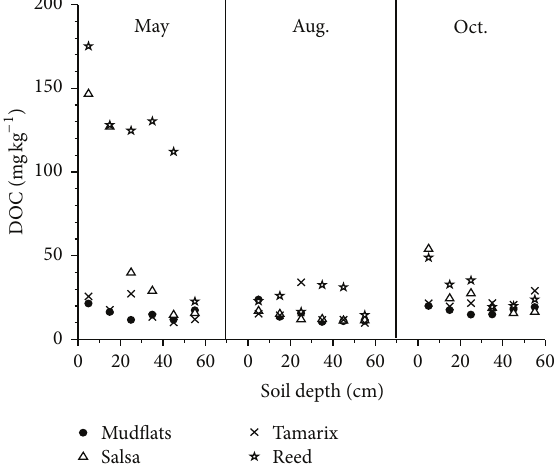
ReedTamarixSalsaMudflatsReedTamarixSalsaMudflatsReedTamarixSalsaMudflats Figure 3: Soil DOC content in four types of Yellow River estuary wetlands. The columns represent the average content of soil TOC, the lines represent the variation range, the number at the right part is the range of TOC, the letters represent the difference of soil DOC in different types of wetlands in the same season, and ∗ means the significant difference at the 0.05 level.